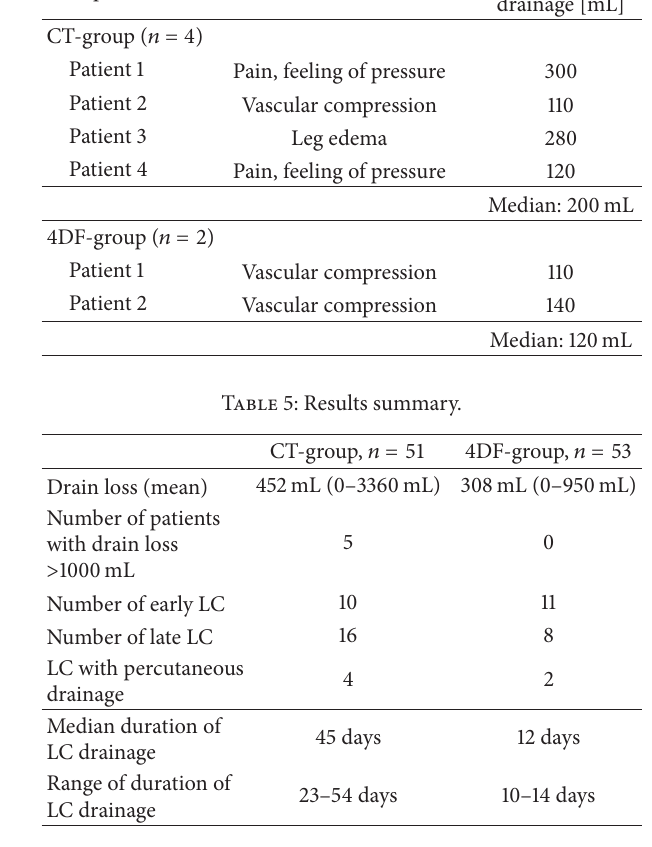
Figure 4: Total number of lymphoceles and number of lymphoceles with treatment, both as a percentage of the respective patient cohort size (CT-group: 51 patients, 4DF-group: 53 patients).